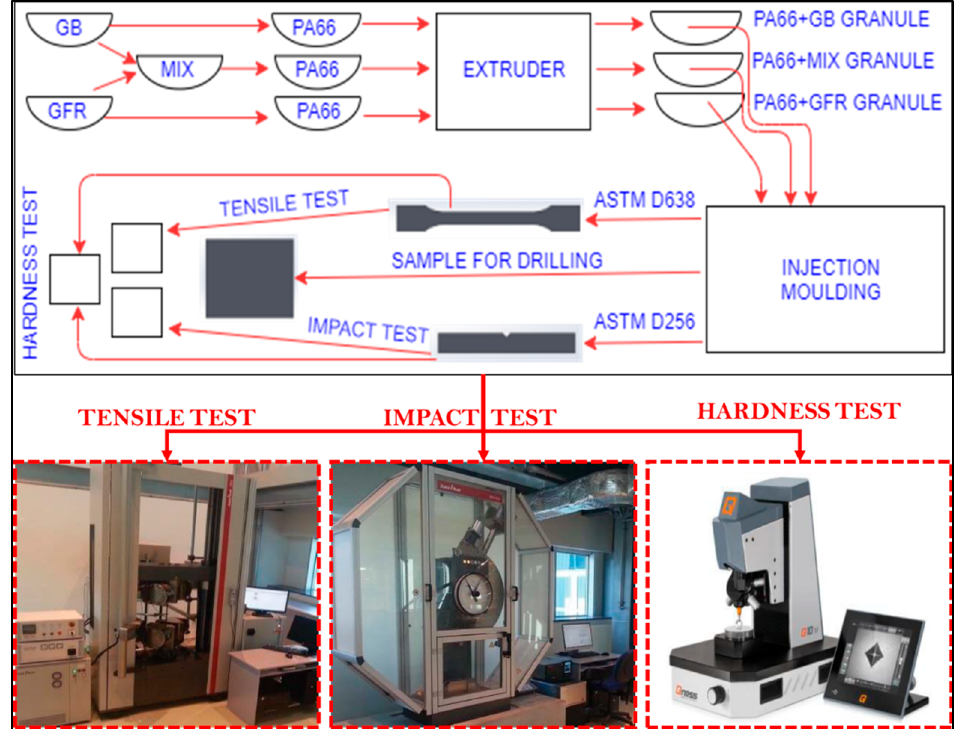
Figure 2. Manufacturing of polymer composites and mechanical test setup.